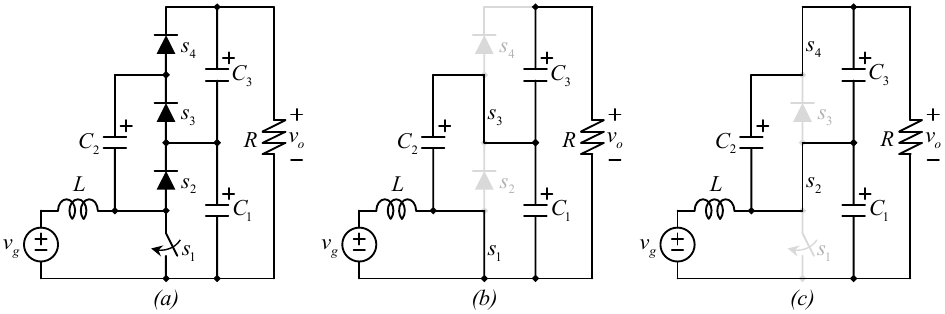
Figure 33. A 2 × multilevel boost converter, ( a ) schematic, ( b ) equivalent circuit when the transistor is closed, and ( c ) equivalent circuit when the transistor is open.